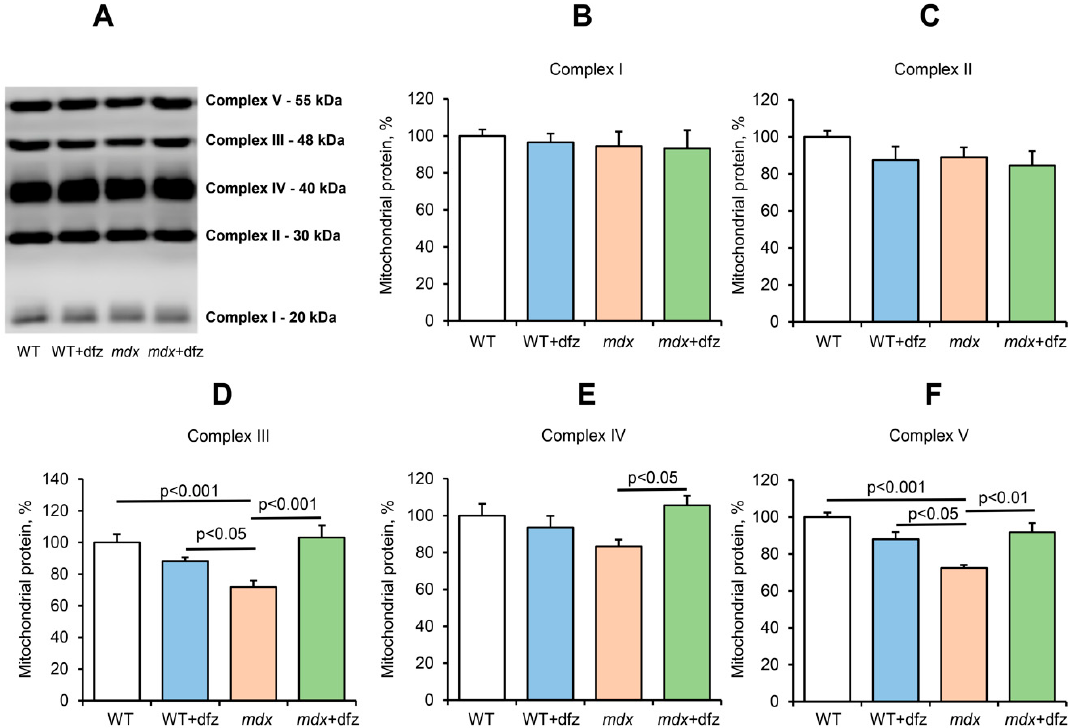
Figure 3. Levels of the proteins of mitochondrial respiratory chain complexes. Data of Western blot analysis ( A ). Relative contents of Complex I ( B ), Complex II ( C ), Complex III ( D ), Complex IV ( E ), and Complex V (ATP synthase, F ). The data are presented as means ± SEM ( n = 6). Mitochondrial dysfunction contributes significantly to lower ATP levels in skeletal muscle.